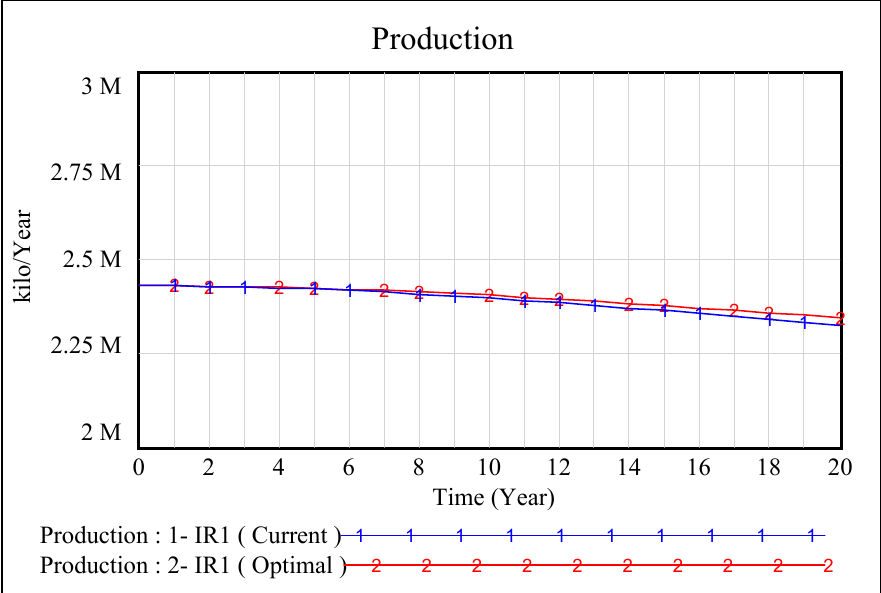
Figure 13. Comparison of the effect of the current and optimal input rate 1 on milk production.